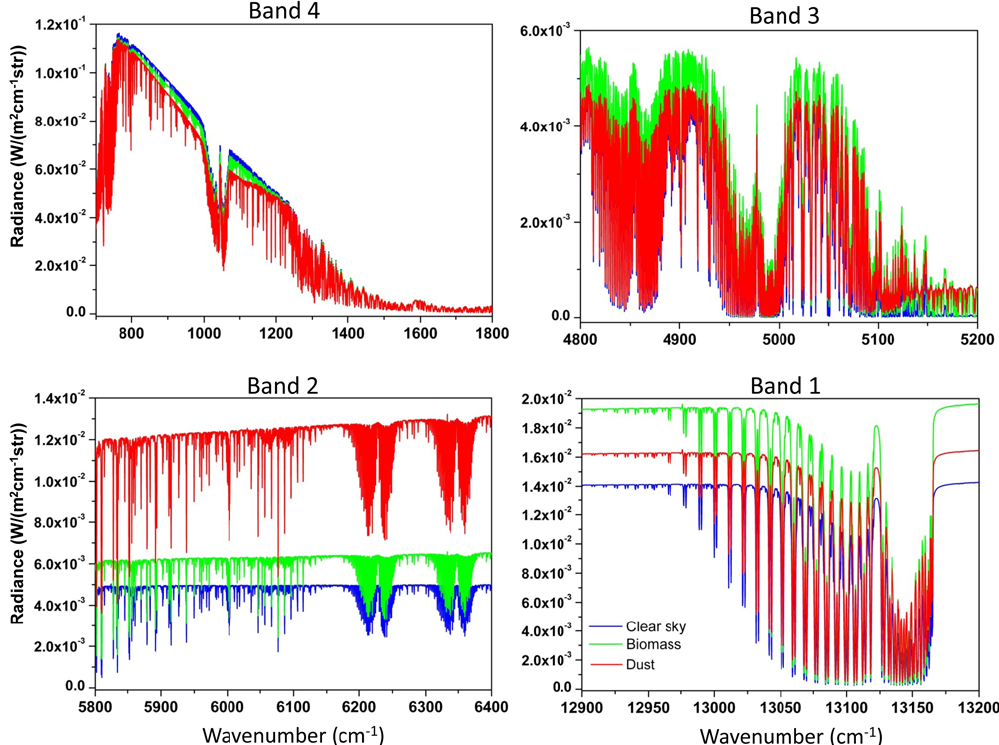
Fig. 1. Simulated TANSO-FTS spectra in radiances (W/(m 2 cm − 1 str)) for clear sky conditions (blue lines), in the presence of biomass burning particles (green lines) with τ (440 nm) = 0.55, and dust (red lines) with τ (1020 nm) = 0.25. Each band is calculated from our line-by- line forward model on US standard profile with nadir viewing angle and solar zenith angle of 30 ◦